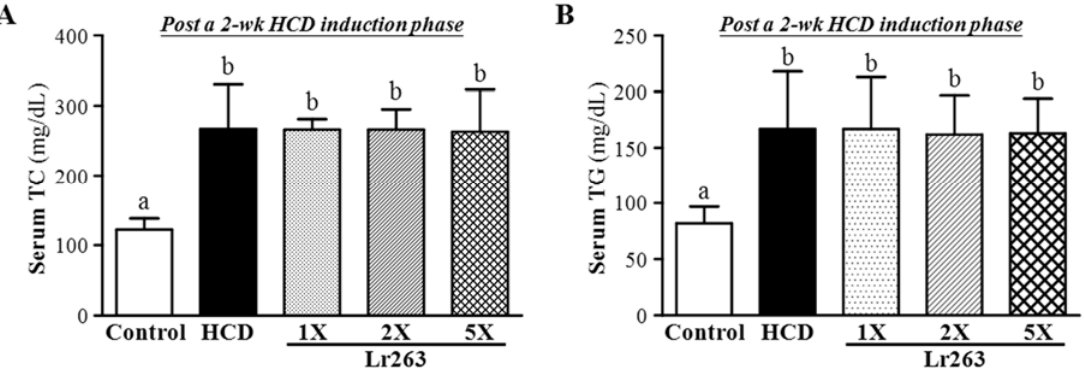
Figure 3. Effect of two-week HCD on serum levels of TC ( A ) and TG ( B ) in hamsters. Data are the mean ± SD, n = 8 hamsters in each group. Columns with different letters (a, b) significantly differ at p < 0.05 by a one-way